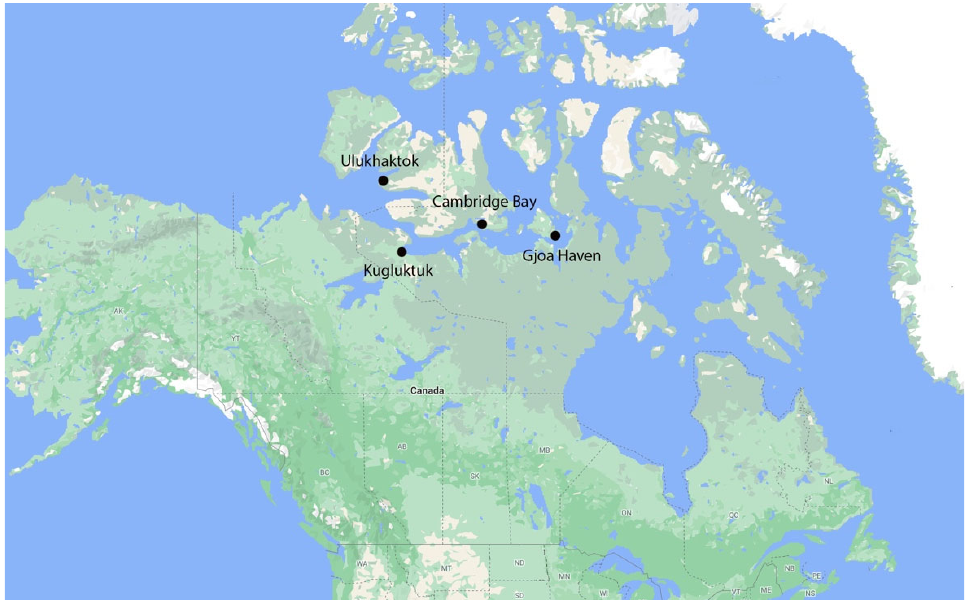
Figure 1. An overview of the Central Canadian Arctic indicating the positions of the four contem ‐ porary Inuinnait communities of Cambridge Bay, Ulukhaktok, Kugluktuk, and Gjoa Haven, located on and around Victoria Island and King William Island. Basemap source: Google Maps.